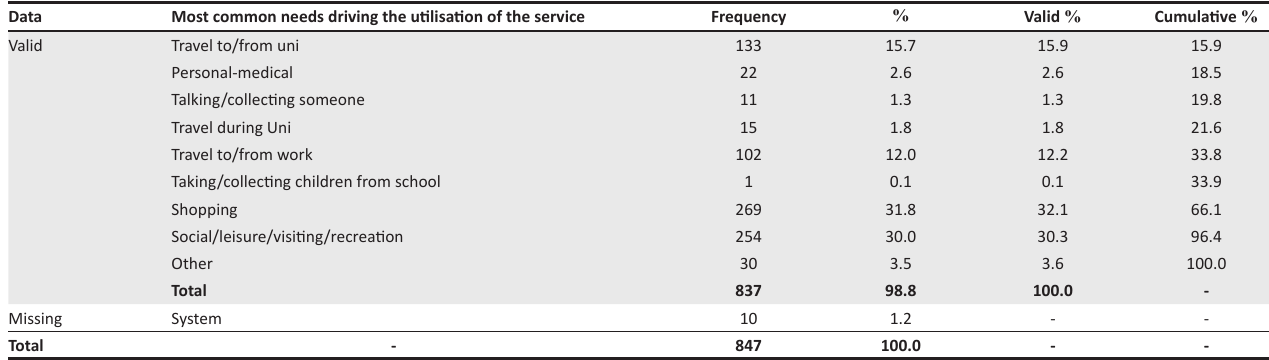
TABLE 3: Purpose for service utilisation.